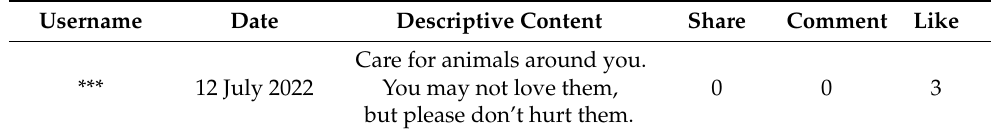
Table 1. A sample of collected information from one post. The username was masked for privacy protection. The original information was Chinese and translated into English here.